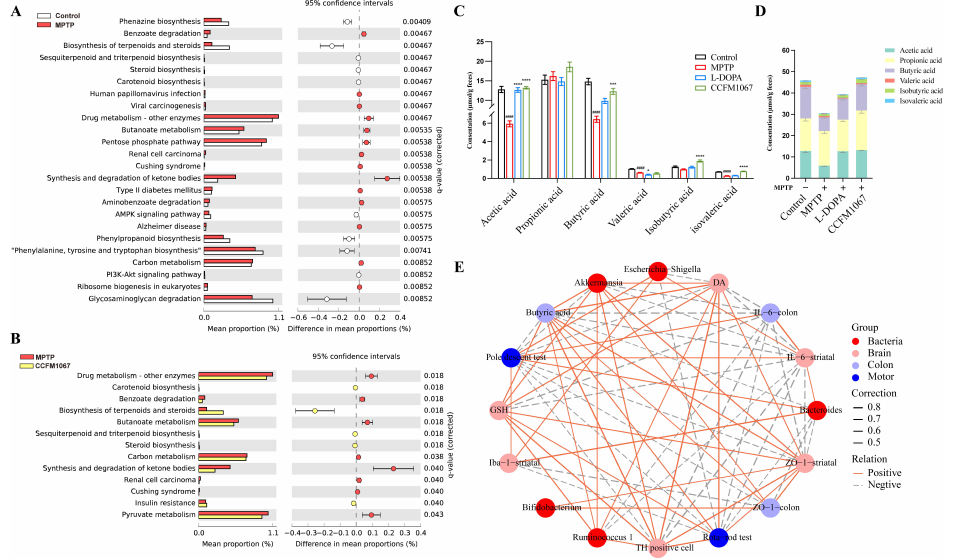
Figure 6. B. breve CCFM1067 treatment affects gut microbial functions in MPTP-induced PD mice, which may be mediated by microbial metabolites. ( A ) Differences in predicted functions between control and MPTP groups in the Kyoto Encyclopedia of Genes and Genomes (KEGG) pathways at level 3 (Welch’s t test, two-sided, Storey FDR q < 0.01). ( B ) Differences in predicted functions be- tween B. breve CCFM1067 and MPTP groups in the KEGG pathways at level 3 (Storey FDR q < 0.05). ( C ) Concentration (µmol/g feces) of SCFAs. ( D ) Total SCFAs: the amount of acetic, propionic, iso- butyric, butyric, isovaleric, and valeric acids add up to the total SCFAs ( n = 5/group). ( E ) A network of correlations between different experimental findings in the microbiota – gut – brain axis. The dif- ferent node colors show different classifications, the red, pink, purple, and blue nodes correspond to the experimental results regarding the gut microbiota, brain, colon, and motor function of the mice. Negative Spearman correlation coefficients are represented by gray, dashed lines (R < −0.5), whereas positive correlation coefficients are shown with solid orange lines (R > 0.5). Spearman cor- relation coefficient values below −0.5 (negative correlation) are indicated with gray dotted lines, and coefficient values above 0.5 (positive correlation) are indicated with solid orange lines. The strength